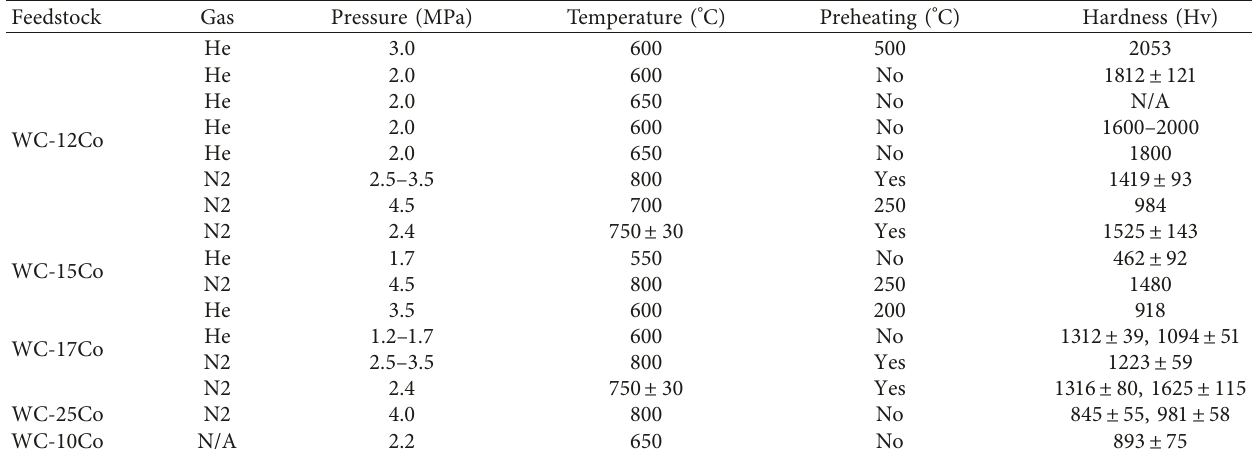
Table 3: Review of working parameters used for producing cold-sprayed WC-Co coatings [84].